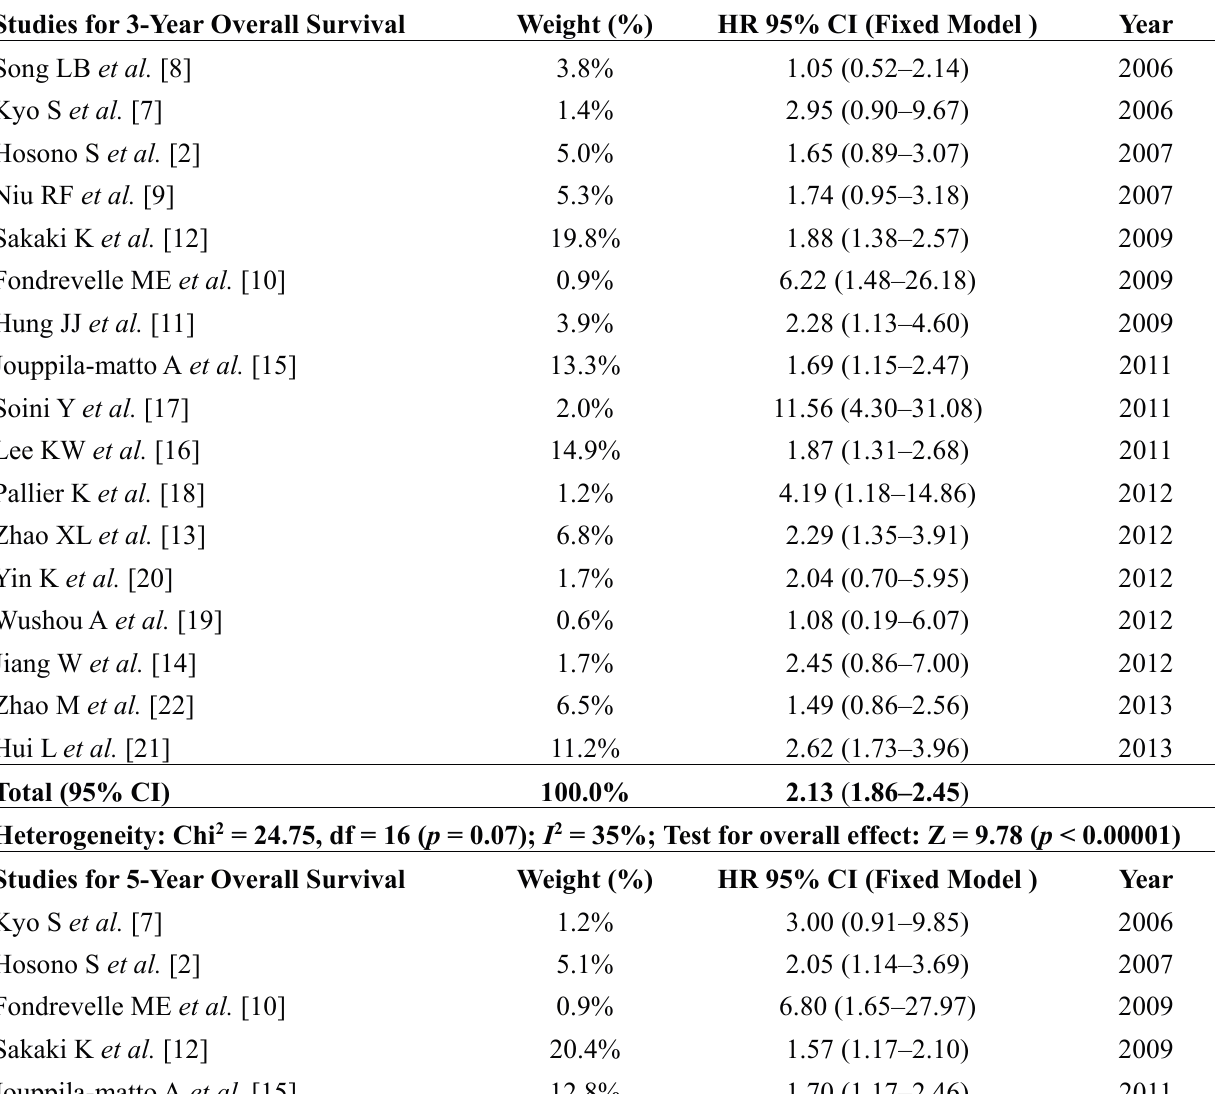
Table 2. The association between Twist-1 expression and overall survival of carcinoma